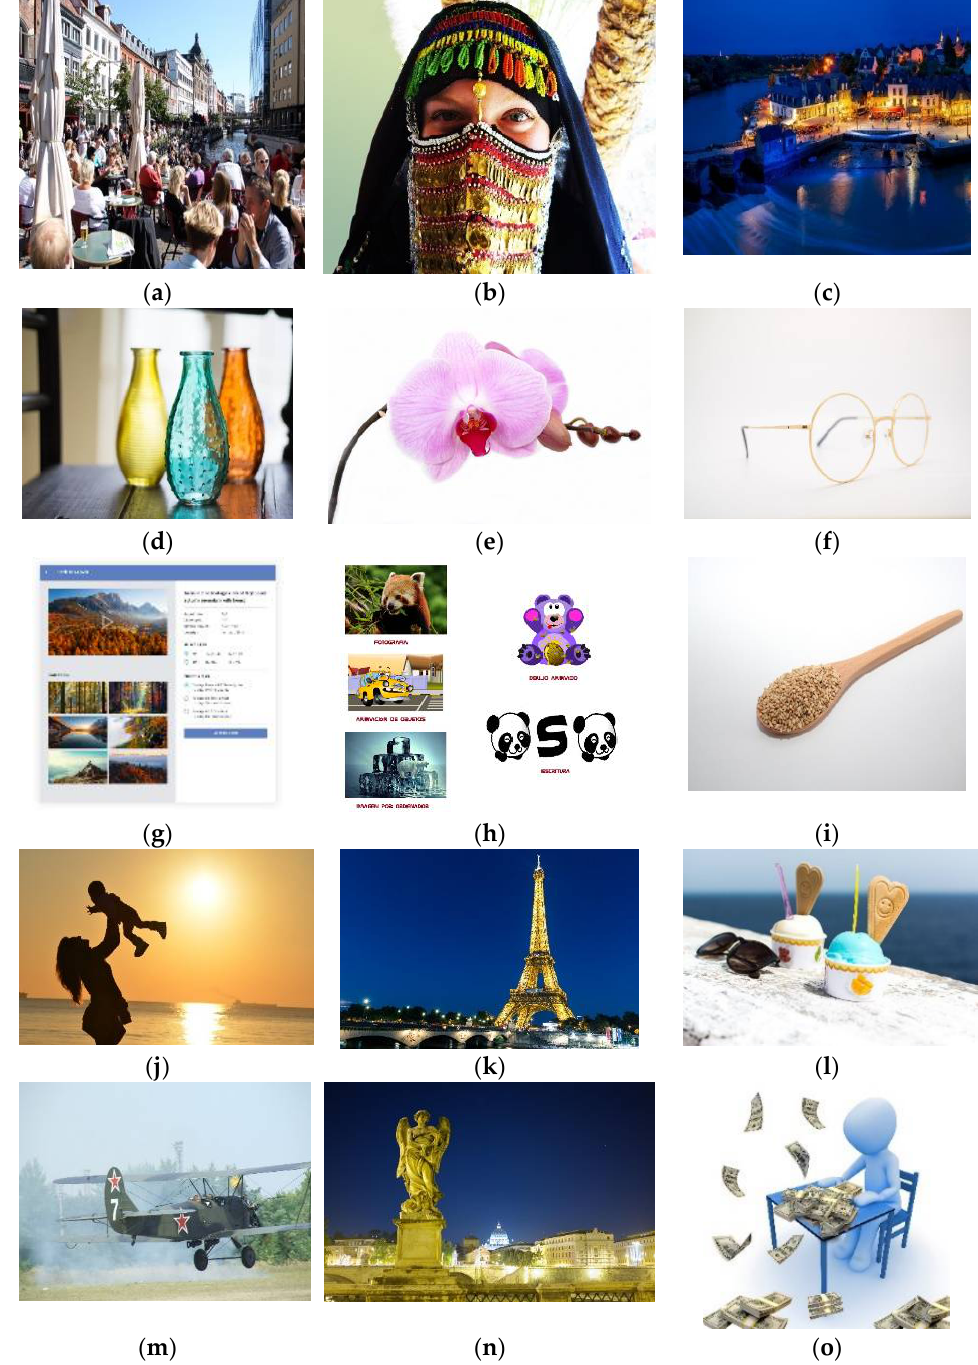
Figure 4. Test images used in experiment: ( a ) Street View, ( b ) Woman, ( c ) Night Scene ( d ) Jars, ( e ) Flowers, ( f ) Glasses, ( g ) Screenshot1, ( h ) Screenshot2, ( i ) Spoon, ( j ) Sunset, ( k ) Paris, ( l ) Ice Cream, ( m ) Air Jet, ( n ) Statue, ( o )